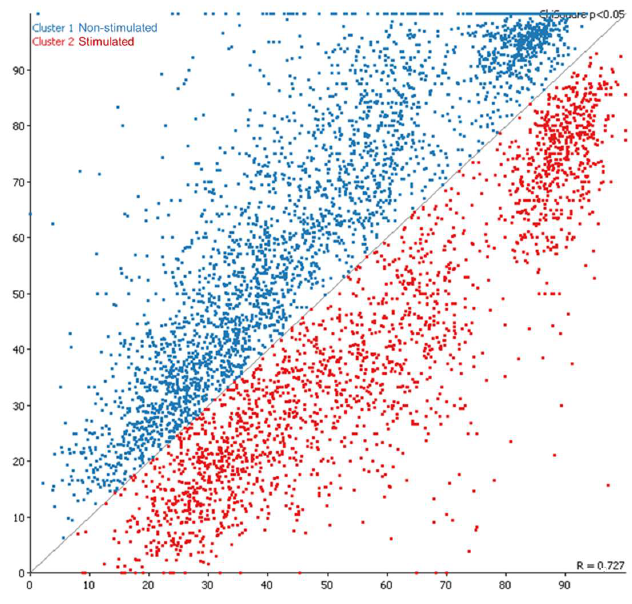
Figure 6. Scatter plot for oocyte 5220 DMRs between non-stimulated and stimulated cows. Amongst the DMRs identified in the merged analysis, we found a domain overlap- ping another member of the DNMT family, DNMT3B , with significantly different meth- ylation percentages of 71.25% for the S group and 79.43% for the NS group. In addition, differences were found in tiles overlapping two genes for methyl CG binding proteins, MBD1 (44.86% vs. 54.87%) and MBD3L1 (33.37% vs. 19.57 in S vs. NS). With the unmerged approach, we obtained a significant number of DMRs as corrob- orated by the principal component analysis shown in Figure 7. Figure 7. Principal component analysis for the 256 oocyte DMRs between a selected number of sam- ples with higher coverage of non-stimulated and stimulated animals. The g:Profiler was used, together with Reactome and WikiPathways databases, to evaluate the functional enrichment analysis of the DMRs. The analysis was made using